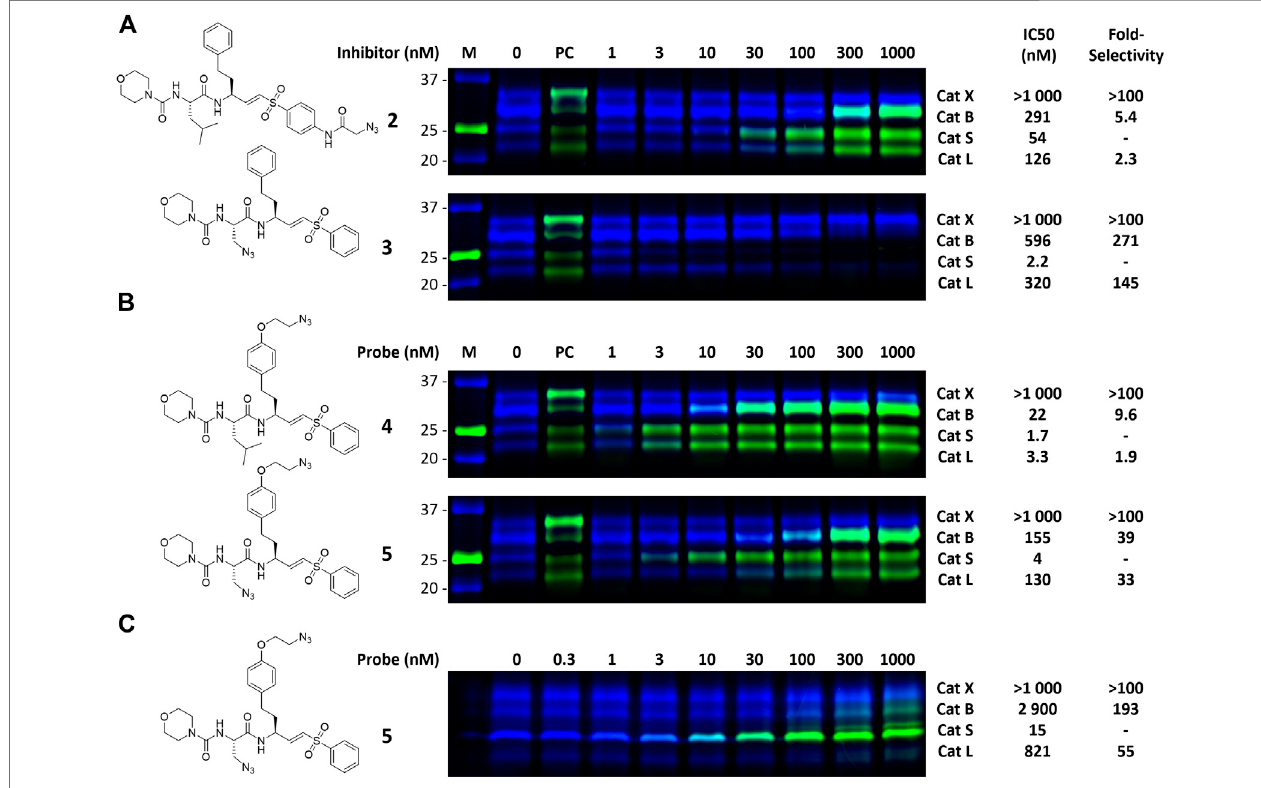
FIGURE 3 | Dual color competitive labeling (A) (B) Whole RAW cells were incubated with indicated concentration of inhibitor/probe for 1 h and residual cathepsin activitywaslabeledwithBMV109(blue)over1 h.CellswerelyzedandtheproteomeswerelabeledwithAF488-alkyne(green)usingcopper-catalyzedclickchemistry (C) Mousebonemarrow-deriveddendriticcellswereincubatedwiththeindicatedconcentrationofinhibitorfollowedbylabelingwithBMV109(blue)andclickchemistrywith AF488-alkyne (green). IC50s were determined by analysis of the competitive labeling by BMV109 and are given in nanomolar. The fold-selectivity for Cat S is calculated from the apparent IC50s. Experiments were performed in duplicate. FJD164 ( Supplementary Scheme S1 ) was used as positive control (PC) for click labeling.